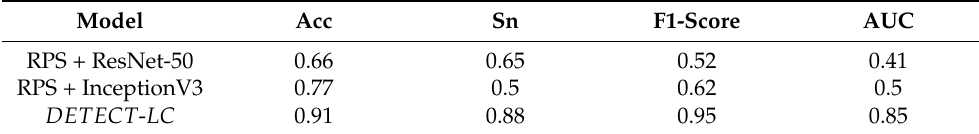
Table 9. Lung Cancer Staging Performance Evaluation on NSCLC Radiomics-Genomics.